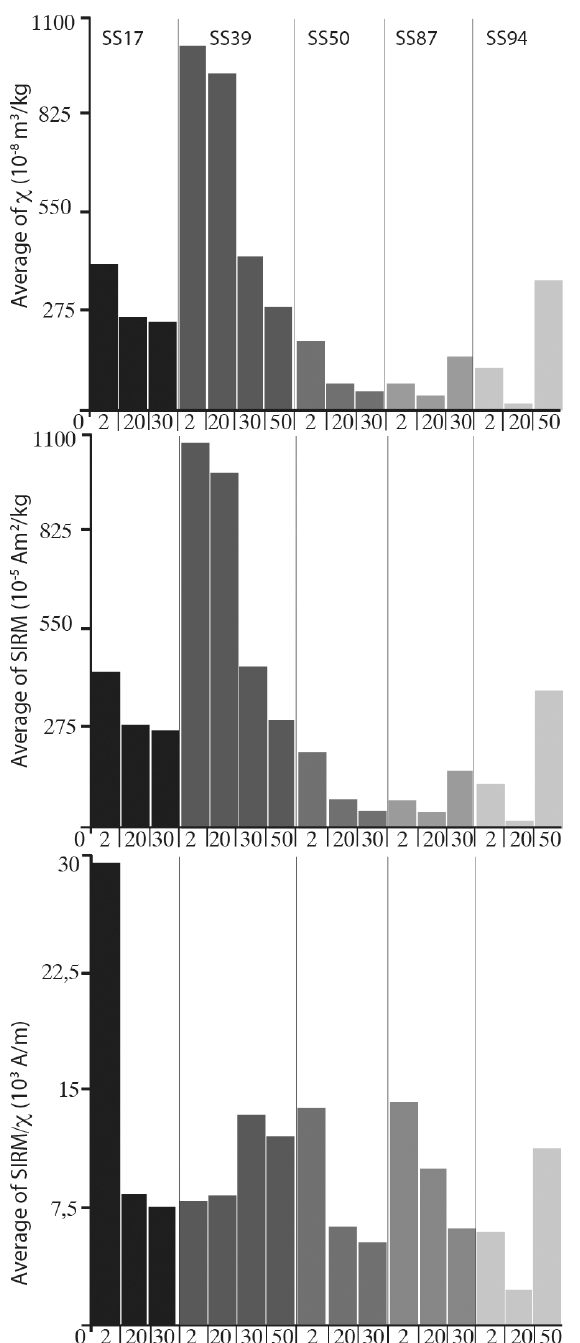
Figure 9. Values of susceptibility, SIRM and SIRM/ | with respect of the distance from the road border, and traffic volume (decreasing from black to light